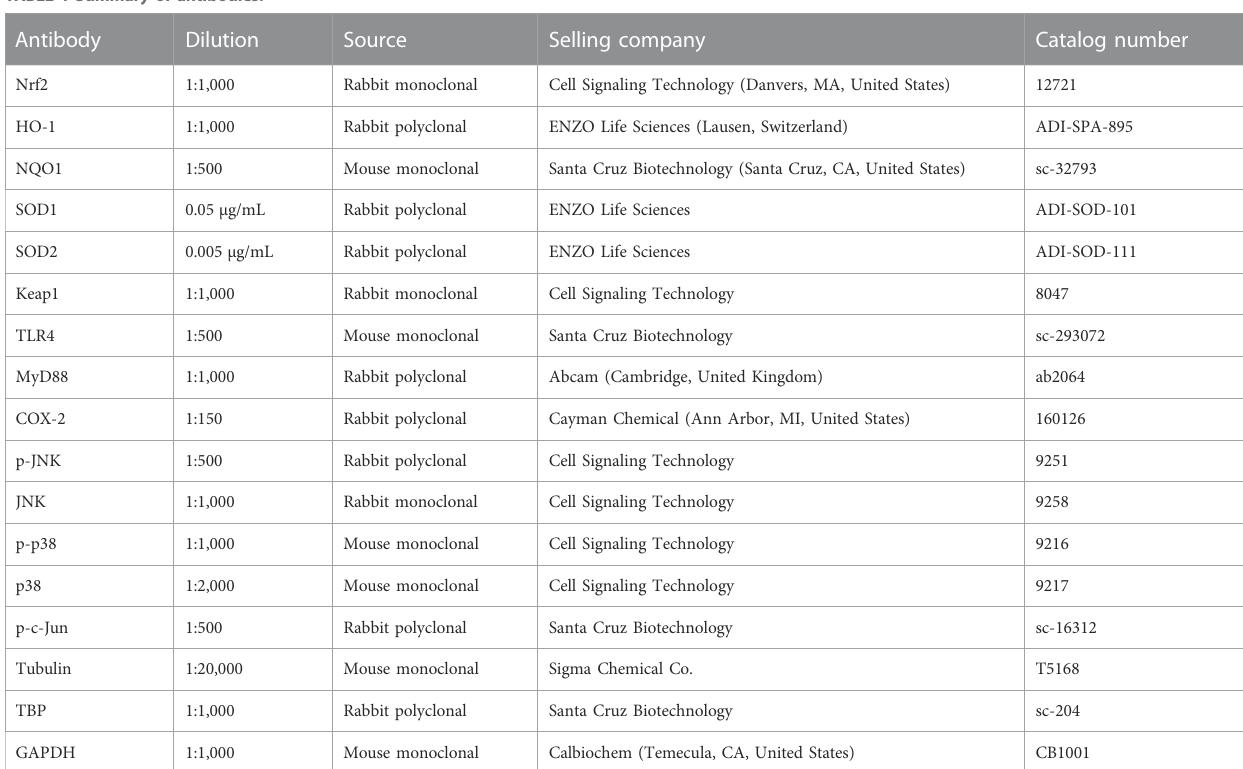
TABLE 1 Summary of antibodies.